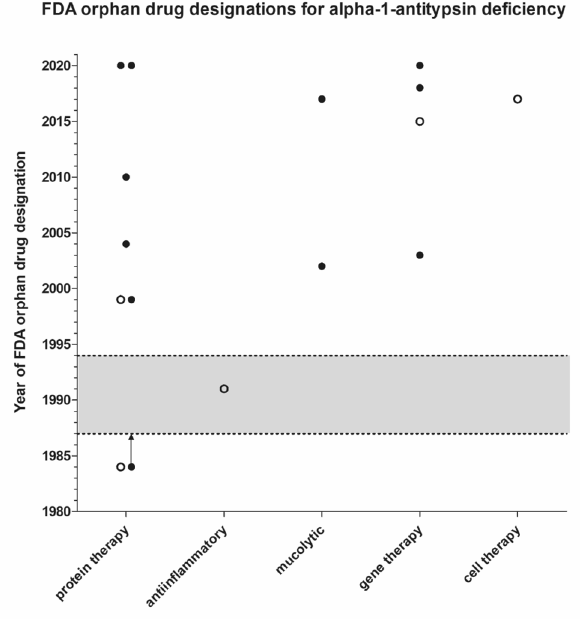
Figure 1. Type of compound intended to treat alpha-1 antitrypsin deficiency by year of FDA orphan drug designation. Full circles: designated compound. Open circles: withdrawn orphan drug designation. Alpha1- proteinase inhibitor (human) received orphan drug designation in 1984 and was approved by the FDA in 1987, the arrow indicates the development time between orphan drug designation and FDA orphan drug approval. The grey area shows the period of marketing exclusivity for this compound between 1987 and